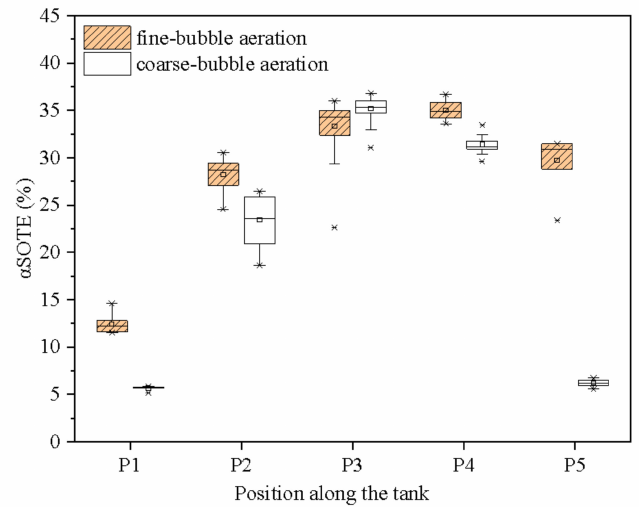
Figure 5. The α SOTE of the different aeration systems at the five